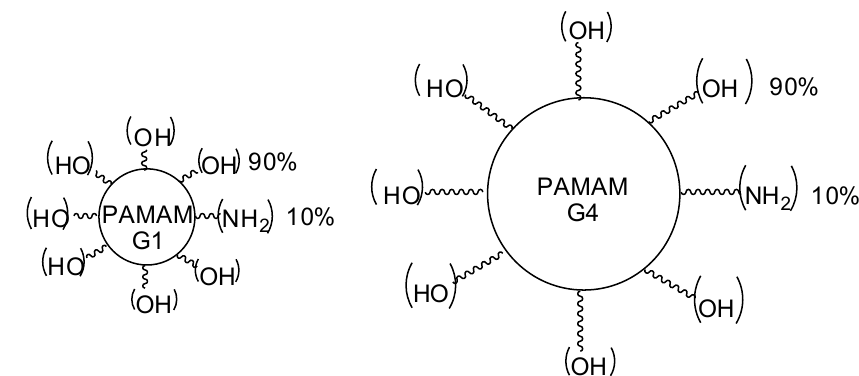
Figure 18. PAMAM-G1 and PAMAM-G4 dendrimers containing mixed surface groups, neutral (–OH—90%) and cationic (–NH 2 —10%) moieties